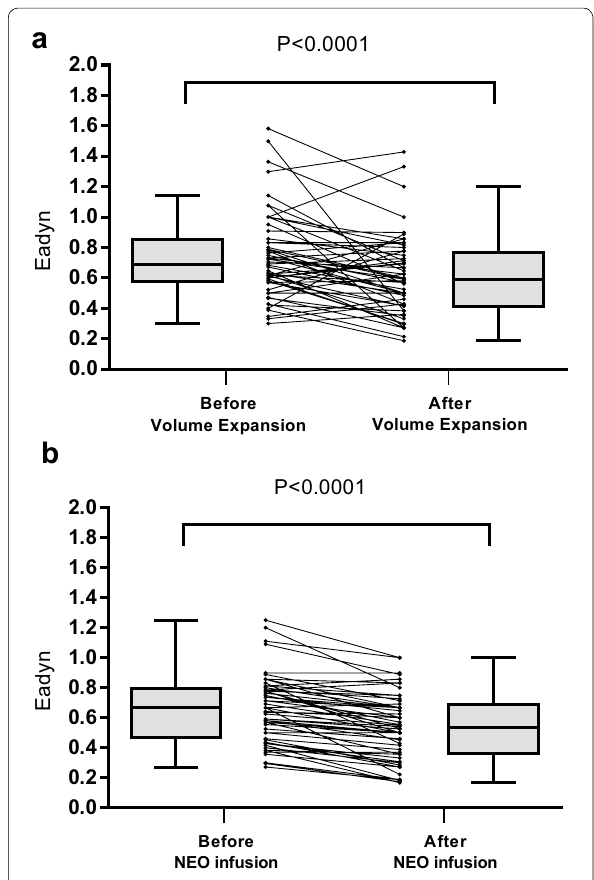
Fig. 2 a Box plot (median values, inter‑quartile range) and individual values of dynamic arterial elastance (Eadyn) before and after volume expansion. b Box plot (median values, inter‑quartile range) and individual values of dynamic arterial elastance (Eadyn) before and after neosynephrine (NEO)